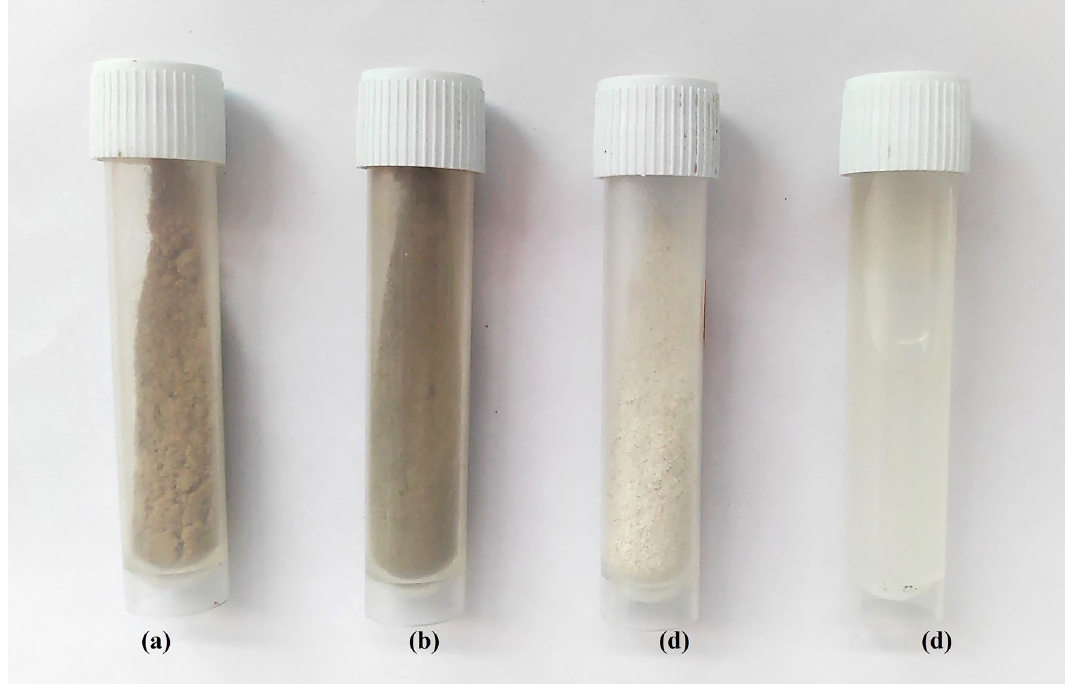
Figure 2. Powdered samples of ( a ) untreated wood ( b ) alkali treated fibres ( c ) bleached fibres and ( d ) nanofibres of Eucalyptus tereticornis